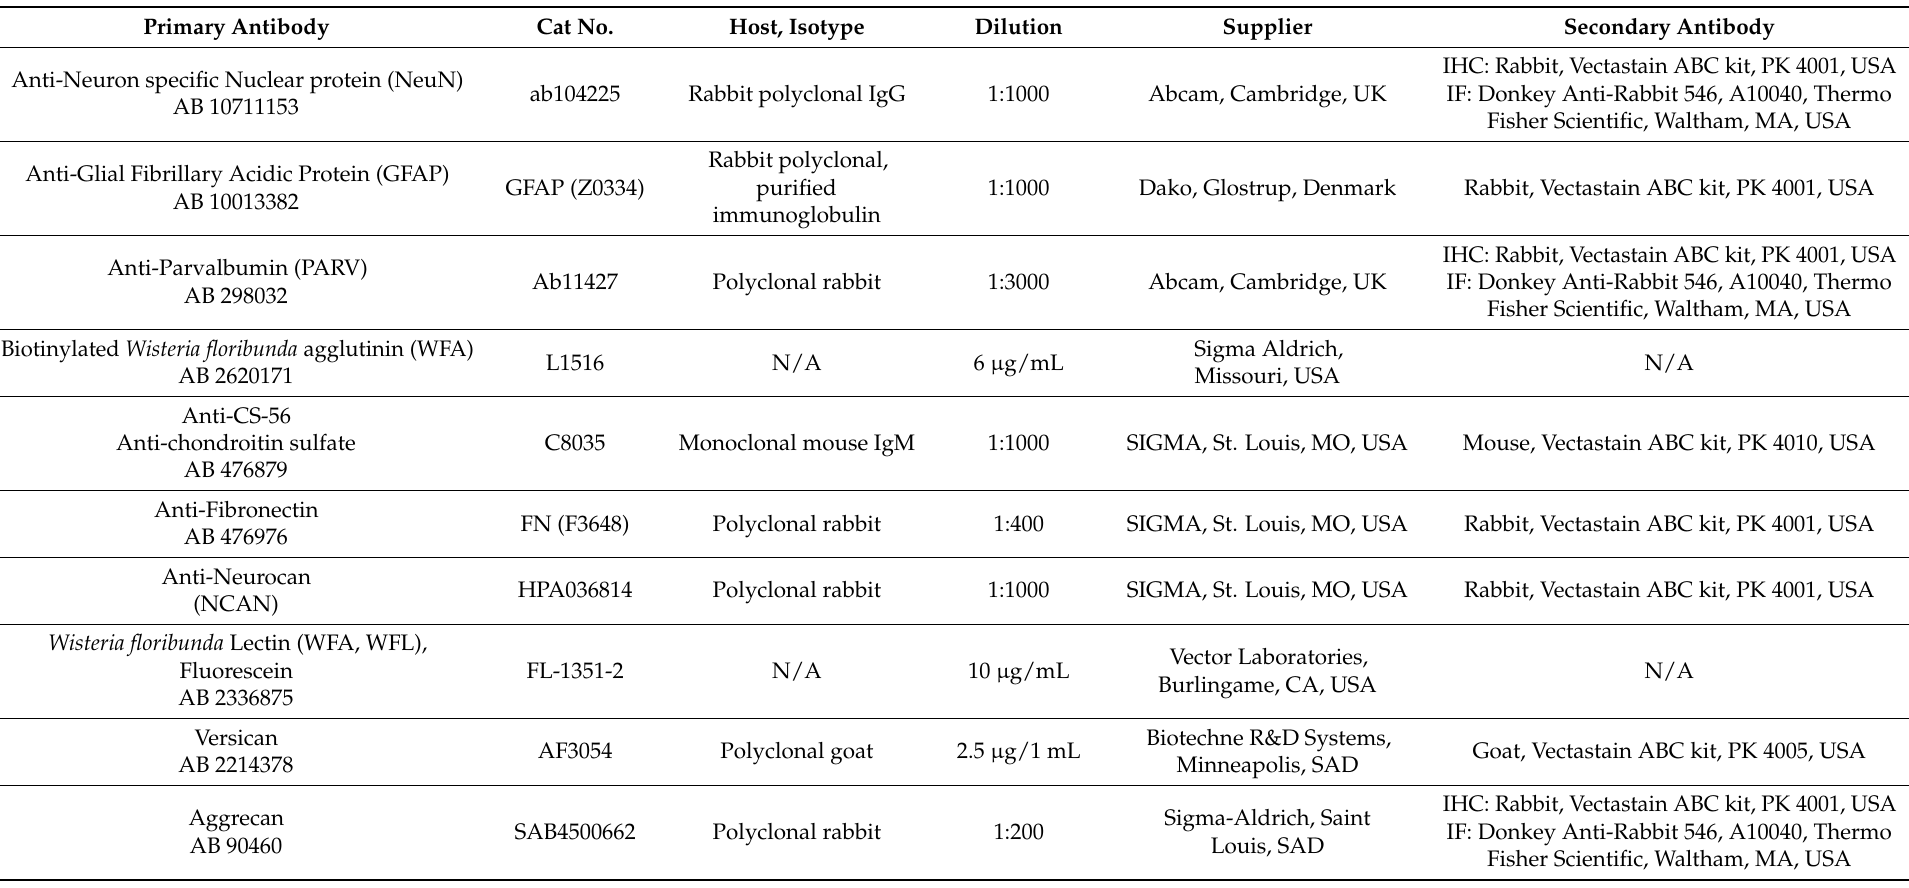
Table 1. List of primary and secondary